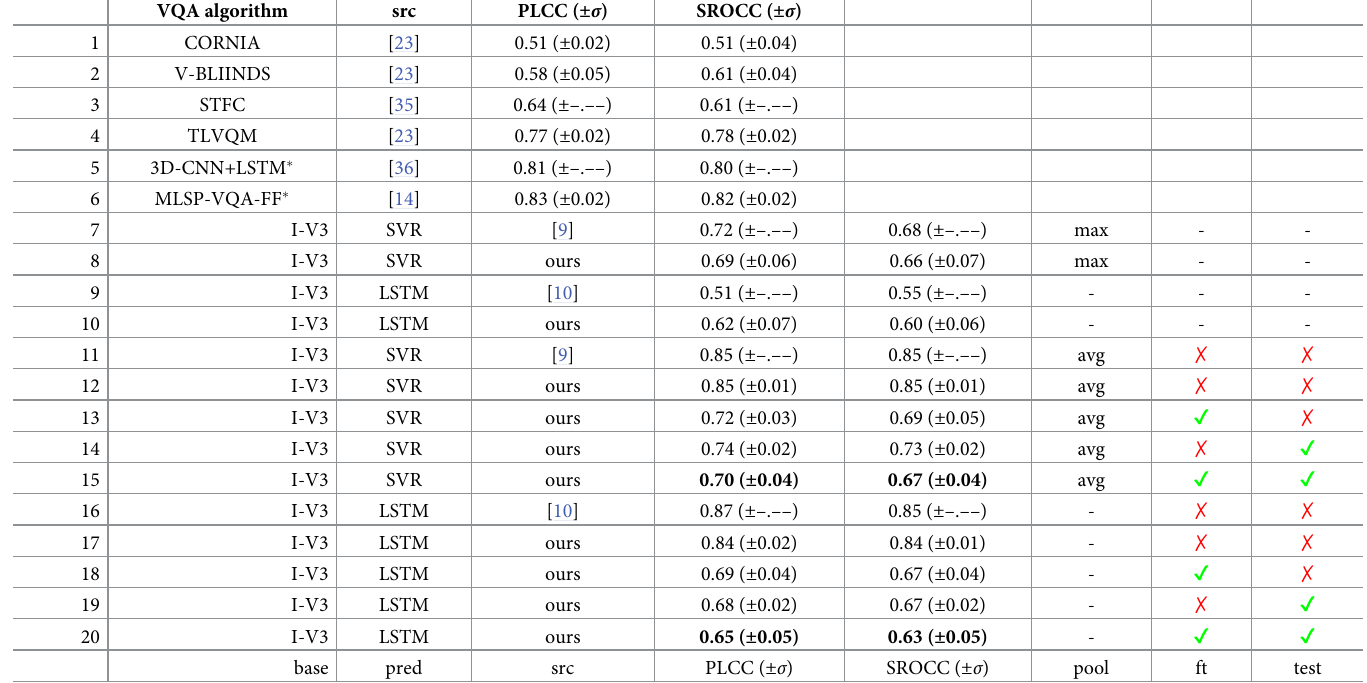
Table 2. Performance results of various VQA algorithms on KoNViD-1k. The data is taken from the references listed in the second column. In the upper half, the first column gives the abbreviated name of the algorithm. The lower half denotes the base architecture used to extract features (column ‘base’) and the model used to predict the overall quality (column ‘pred’). The last two columns designate whether fine-tuning (column ‘ft’) was performed correctly (green checkmark), or with data leakage (red cross), and whether the test set (column ‘test’) was independent (green checkmark) or tainted (red cross). The two approaches indicated by � were published after the refer- enced publication and are current state-of-the-art. –.–– indicates unreported values. The numbers in bold font in lines 15 and 20 give the true performance of CNN-SVR and CNN-LSTM, much below the claimed performance. VQA